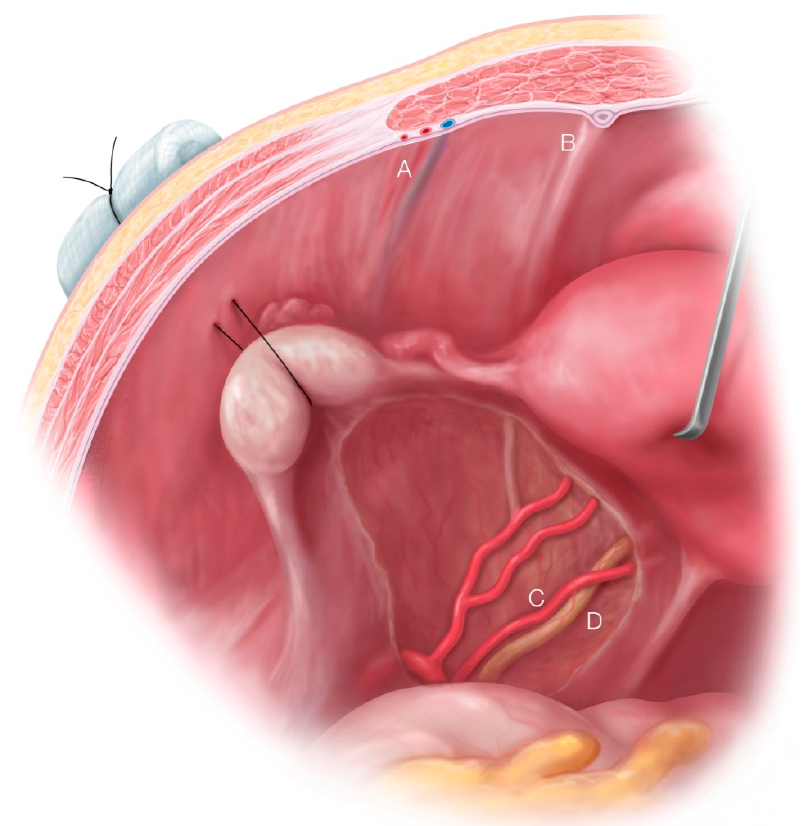
Figure 4. Illustration showing left suspended ovary to the anterior abdominal wall after endometriosis surgery with important anatomical structures. ( A ) Inferior epigastric vessels in the lateral umbilical fold. ( B ) Medial umbilical ligament. ( C ) Uterine Artery. ( D ) Ureter.